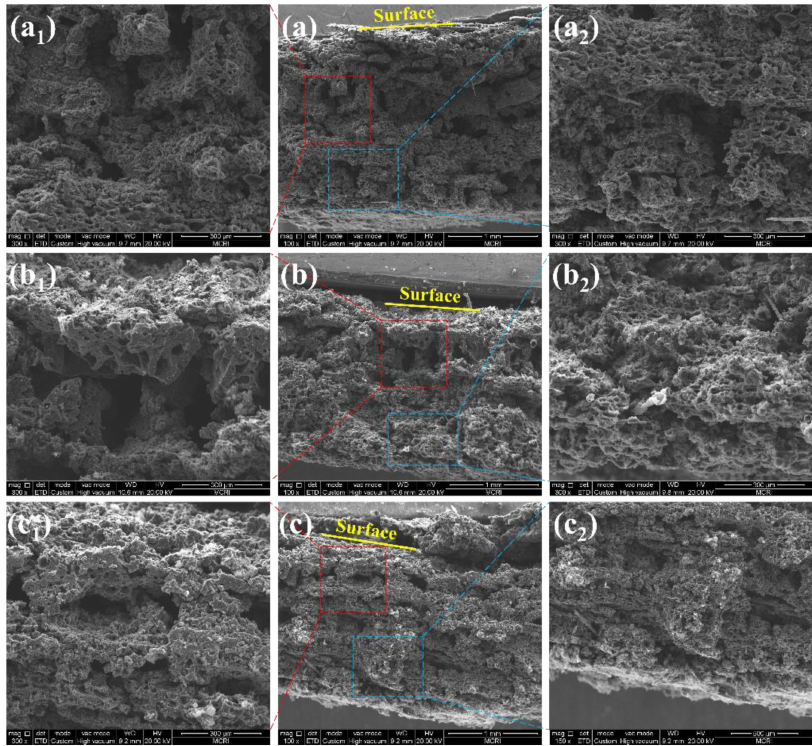
Figure 15. The SEM micrographs of the cross-section of the char layer. (AM/HM) 20 : ( a ); (AM/HM) 40 : ( b ); (AM/HM) 80 : ( c ). ( a 1 , a 2 , b 1 , b 2 , c 1 , c 2 ) are the partial magnification of ( a , b , c ),